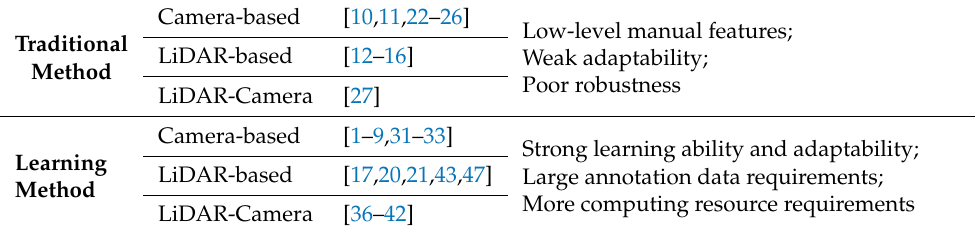
Table 1. In the off-road scene, the intensity of ambient light has a great impact on the camera. LiDAR’s point cloud has rich 3D structure information, which is more robust to describe the